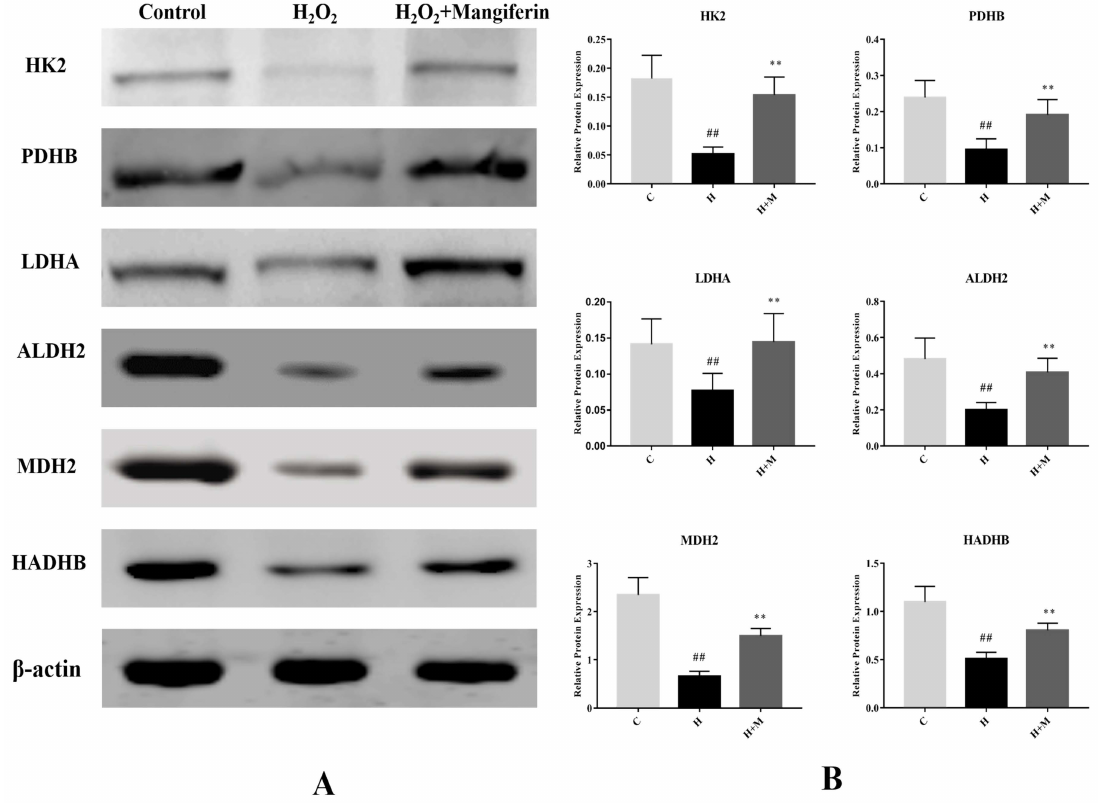
Figure 6. Western blot validation of HK2, PDHB, LDHA, ALDH2, MDH2, and HADHB. ## p < 0.01 versus the control; * p < 0.05 and ** p < 0.01 versus the H 2 O 2